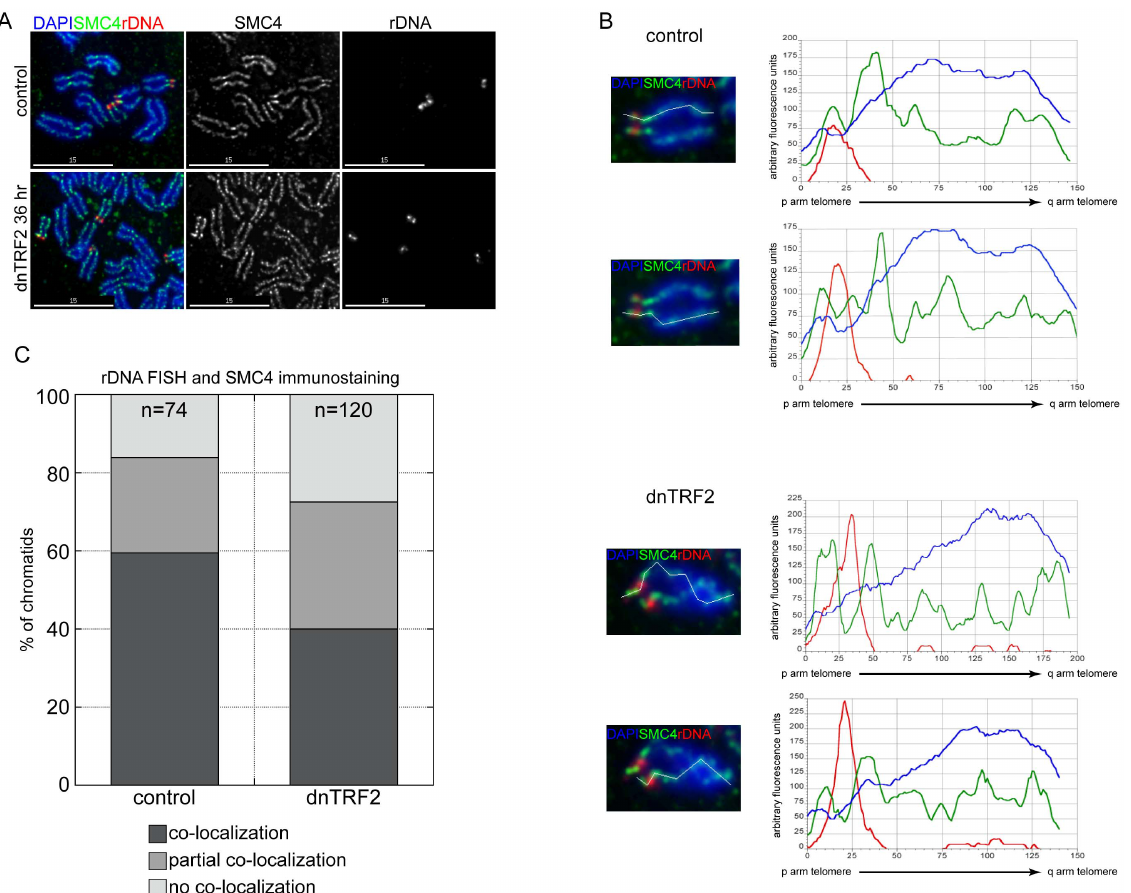
Figure 5. Condensin localization decreases on acrocentric short arms in the presence of dnTRF2. Combined immunostaining-FISH for (A) SMC4 (green) and rDNA (red) on metaphase chromosomes from control and 36 hour dnTRF2-expressing cells. (B) The amount of SMC4 was quantitated by measuring arbitrary fluorescence along the length of the chromosomes and plotting signal intensity as a line plot. A line begins at the p arm (0 on x-axis) and extends to the telomere of the q arm ( , 150 + on x-axis). (C) The extent of rDNA and SMC4 co-localization at chromatids of metaphase chromosomes is presented in graphical format. The number of individuals chromatids examined is indicated at the top of each bar. A significant reduction in SMC4 co-localization at rDNA was observed on metaphase chromatids from cells expressing dnTRF2 for 36 hours. Scale bars in (A) are 15 micrometers.